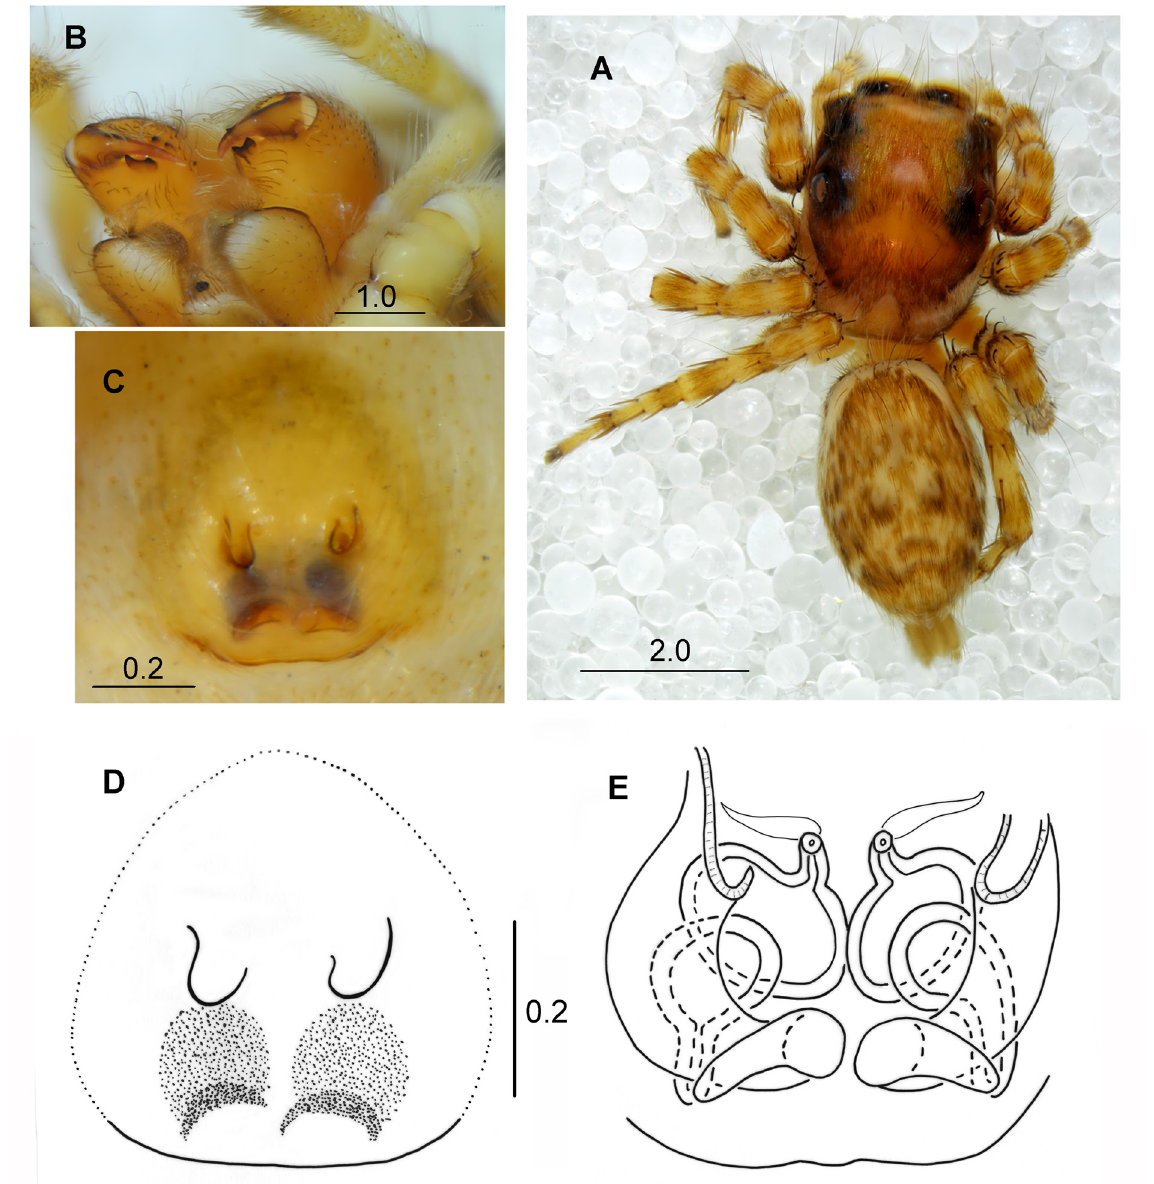
Fig. 72. Tusitala bandama sp. nov., holotype, ♀ (MNHN). A . Habitus, dorsal view. B . Chelicerae. C–D . Epigyne. E . Internal structure of